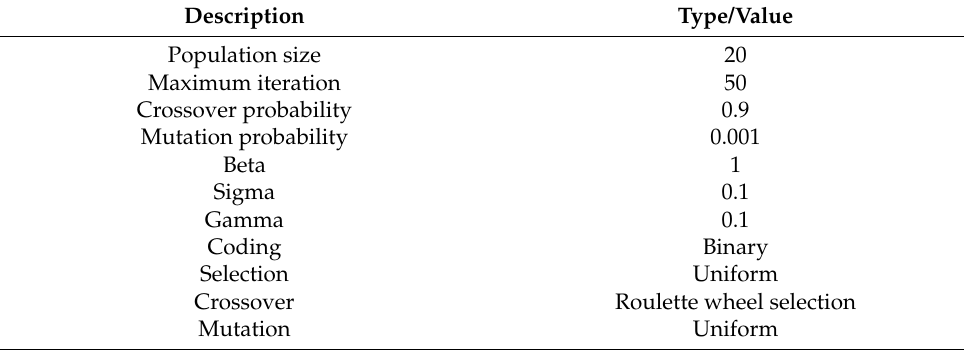
Table A2. Parameters of the